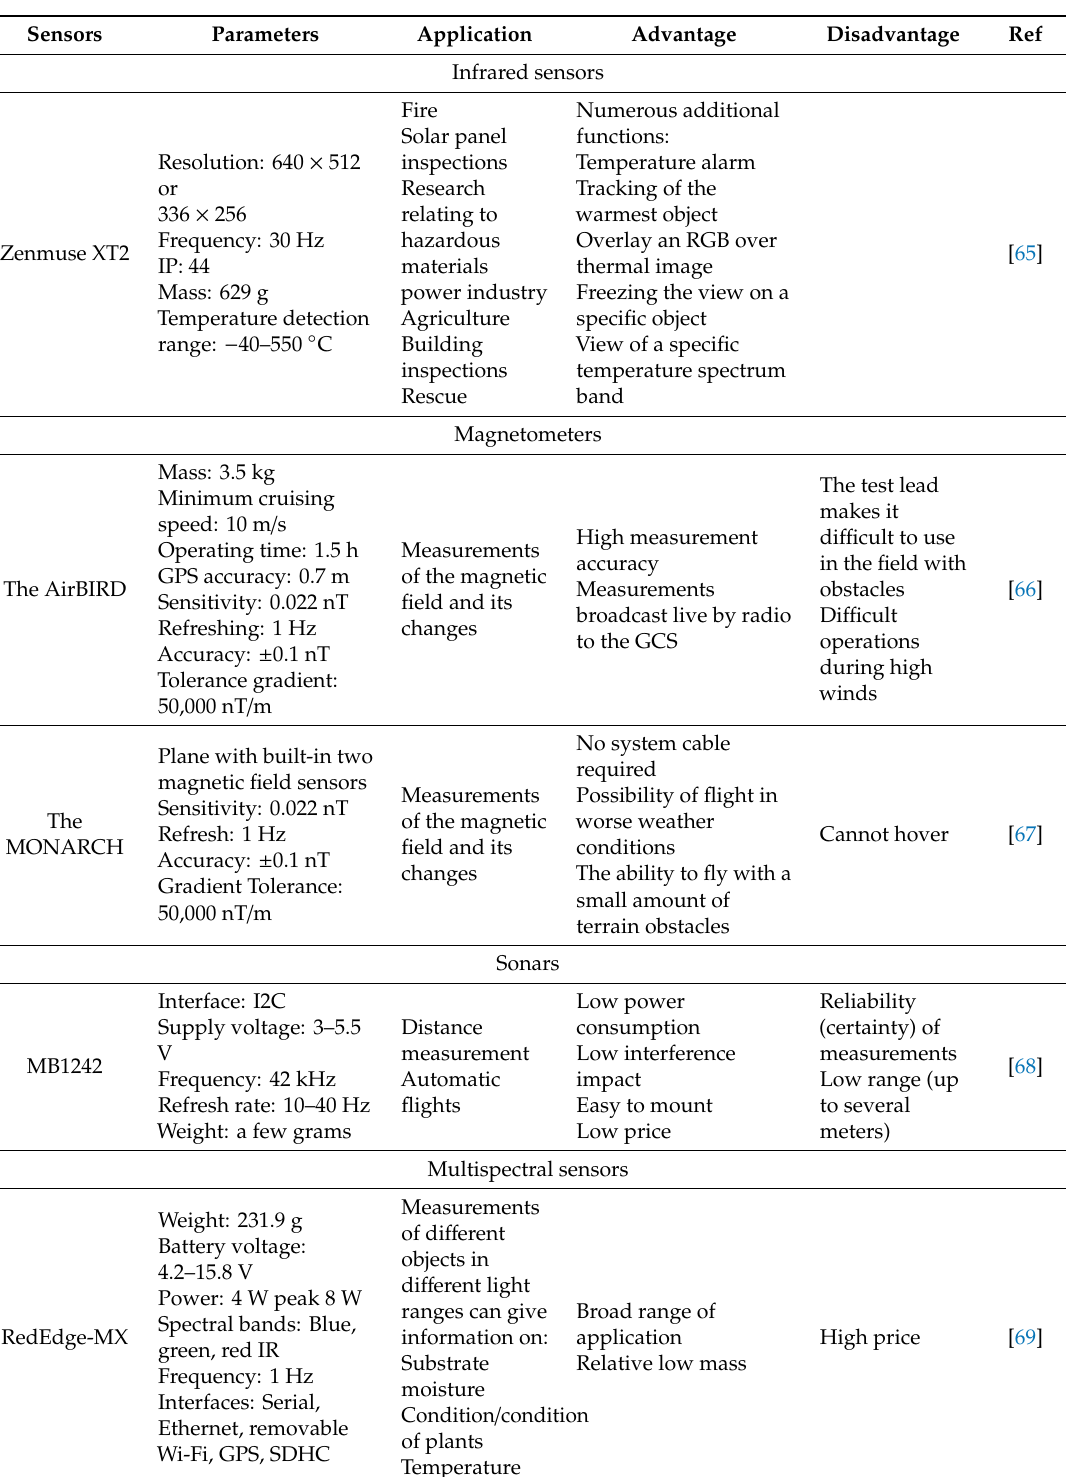
Table 2. Characteristics of selected